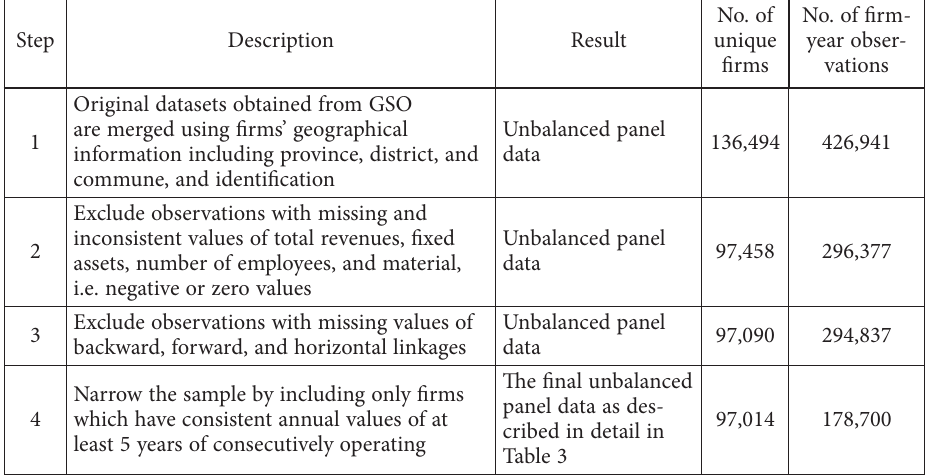
cri bed in detail in Table